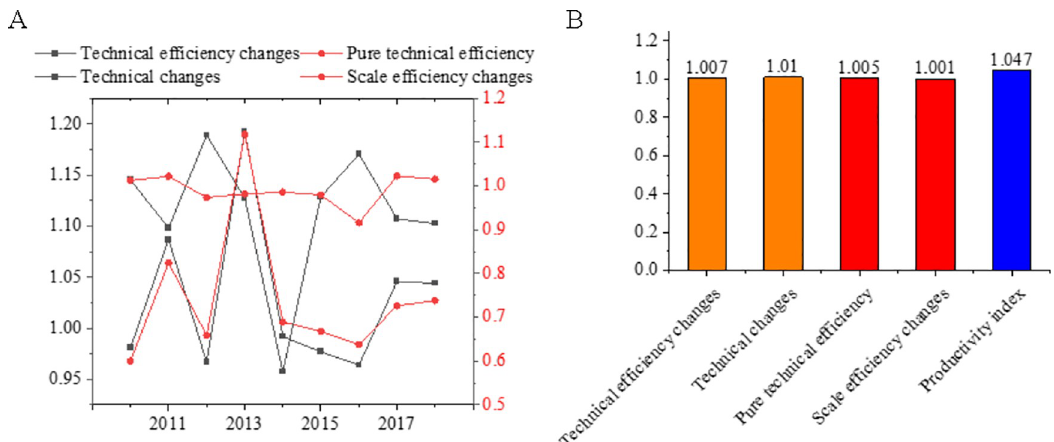
Fig 11. National high-tech IDZs’ productivity index and decomposition results in different